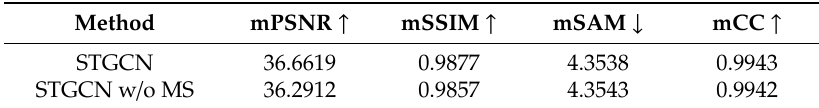
Table 7. Quantitative evaluation of cloud removal algorithms with and without multi-scale module. w / o is short for without.